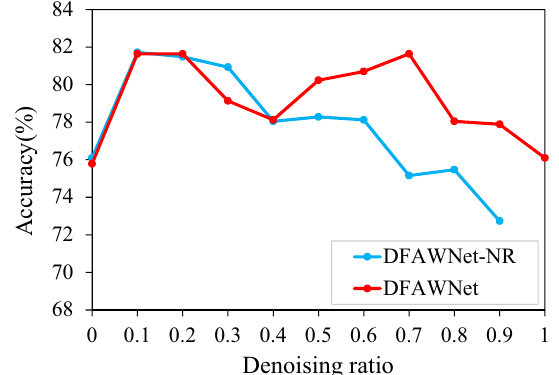
features of the three states into two parts. The features grouped by DFAWNet are more discriminative between state 2 and 3 (green and yellow points). These results sug- gest that DFAWNet is better than other 8 models in terms of robustness against operating condition variation.